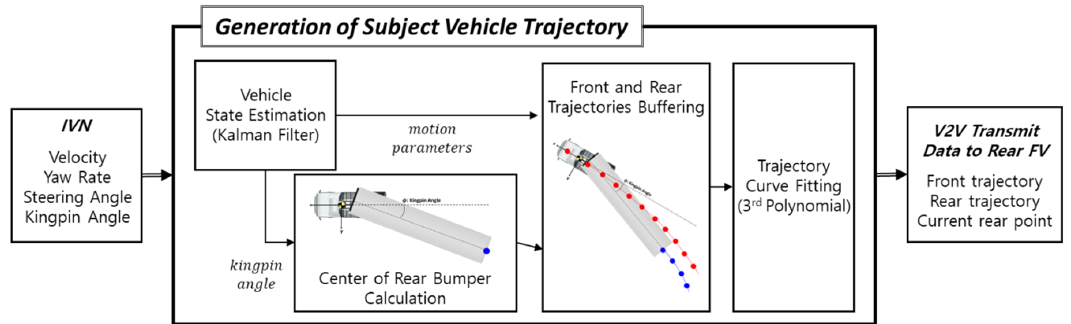
Figure 7. Architecture of subject vehicle trajectory generation.